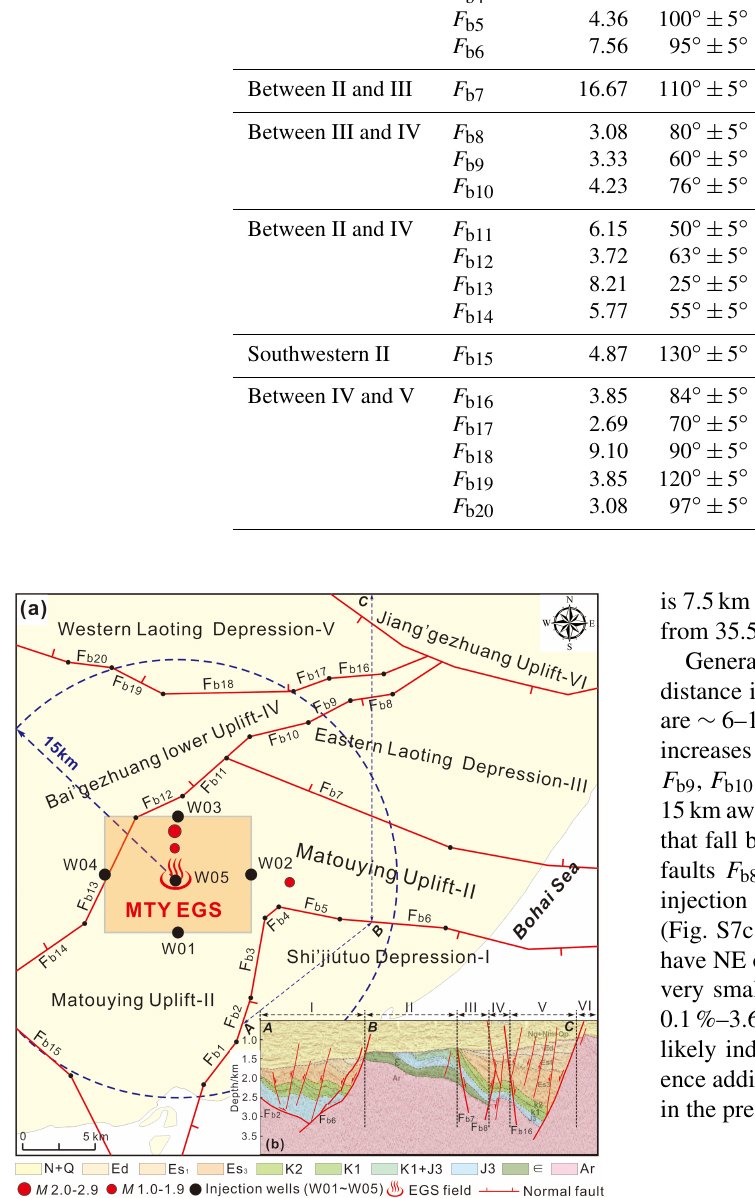
Figure 11. (a) Geological structures and active faults within a range of ∼ 15–20km away from the MTY EGS field. (b) The structural framework of the Matouying uplift and its vicinity from integrated seismic and geological data